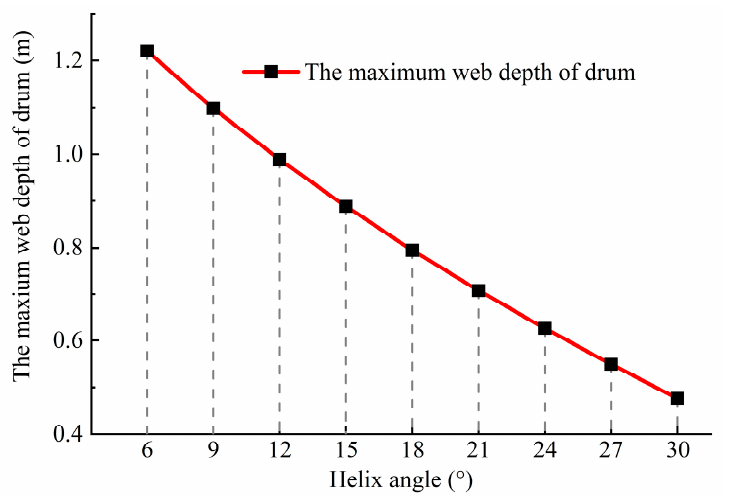
Figure 6. The diagram of the relationship between maximum web depth and helix